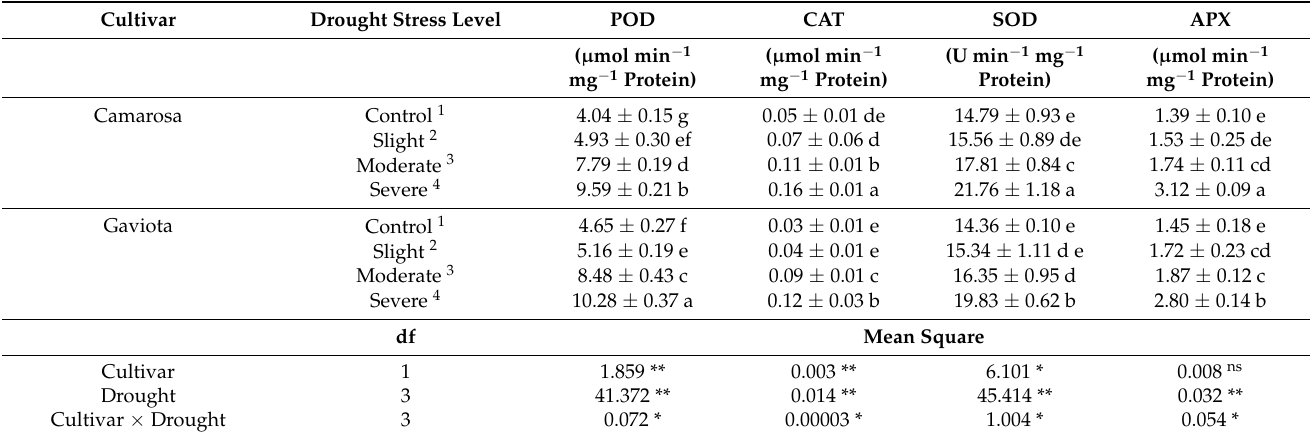
Table 2. Effects of different drought stress levels on antioxidant enzyme activity (peroxidase (POD), cata- lase (CAT), superoxide dismutase (SOD), and ascorbate peroxidase (APX)) in two strawberry cultivars.